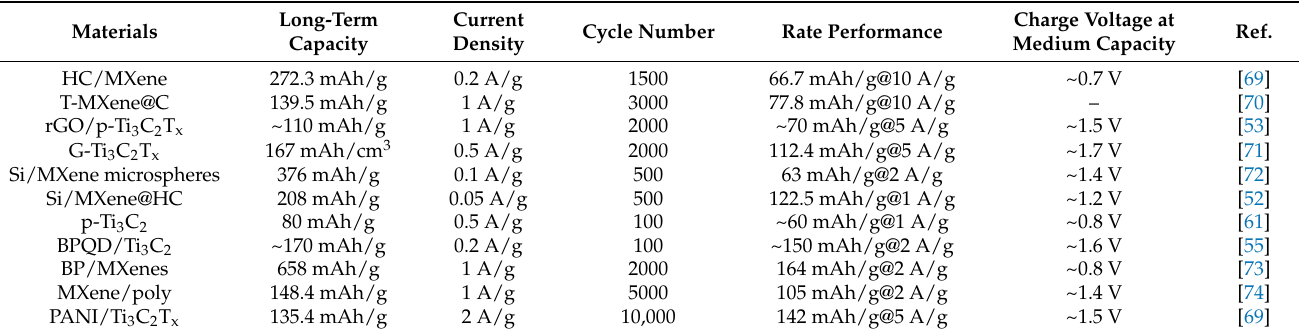
Table 2. Performance comparison of different nonmetal/MXene composites in